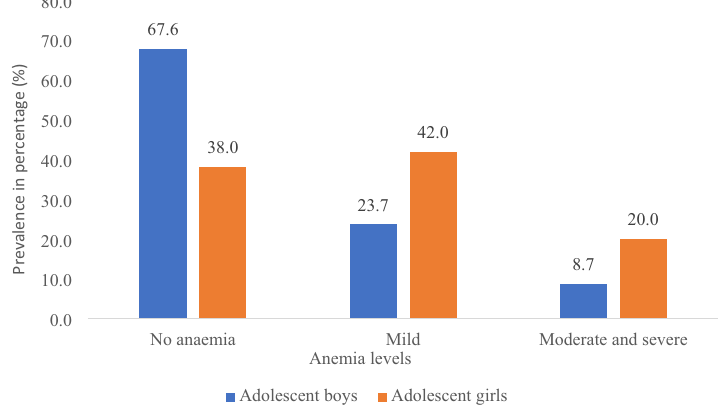
Figure 1. Prevalence of anaemia among adolescent boys and girls. Adolescent boys, adolescent